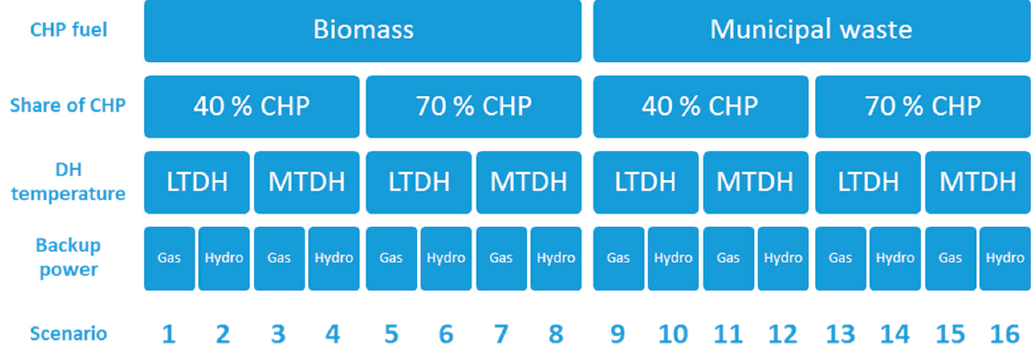
Figure 1. Illustrative figure of the 16 different scenarios in the study, depending on the CHP fuel, the